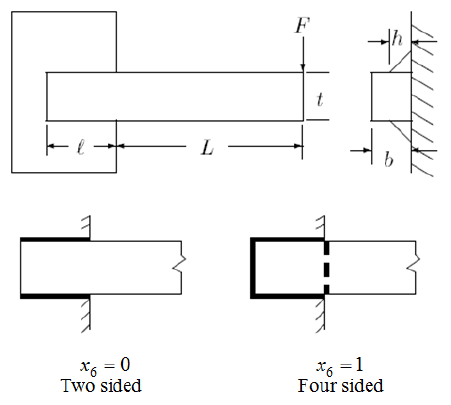
Figure 3. Welded joint configurations of the 2nd variation of welded beam design problem.